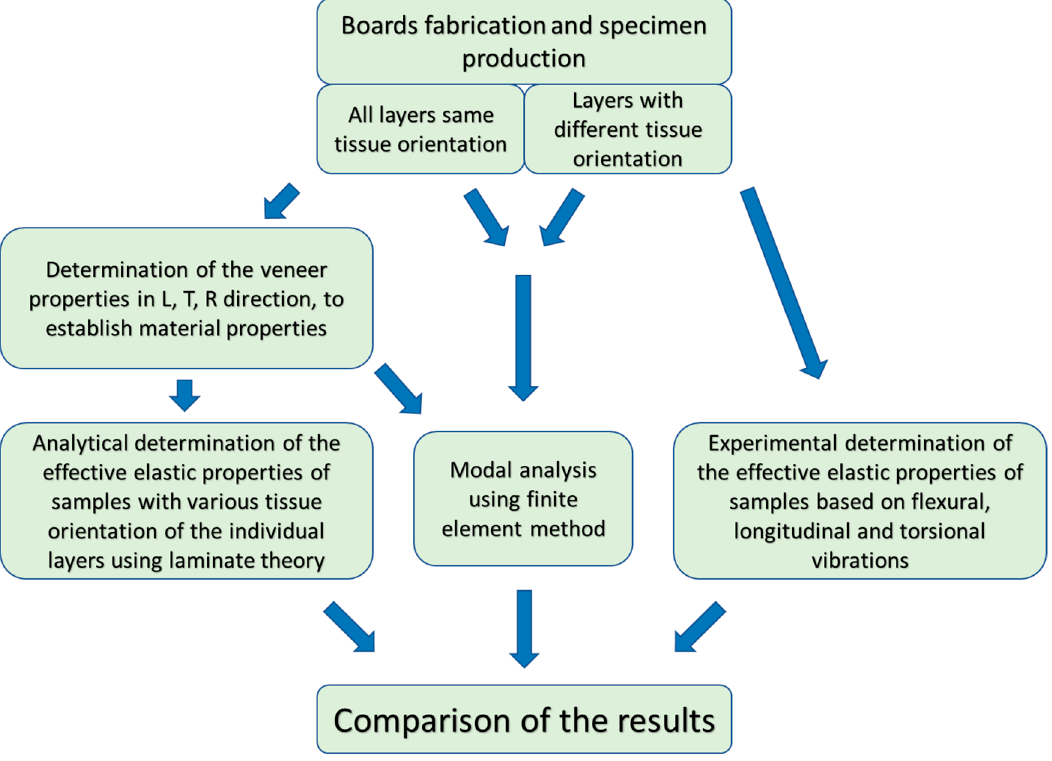
Figure 1. Experiment design.